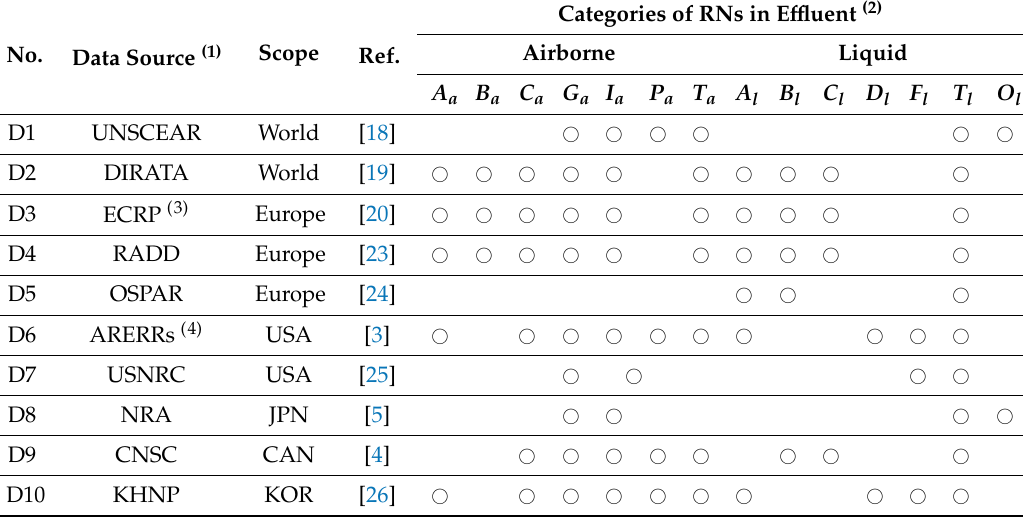
Table 1. Sources of information on radioactive e ffl uent from NPPs open to the public together with respective categories of